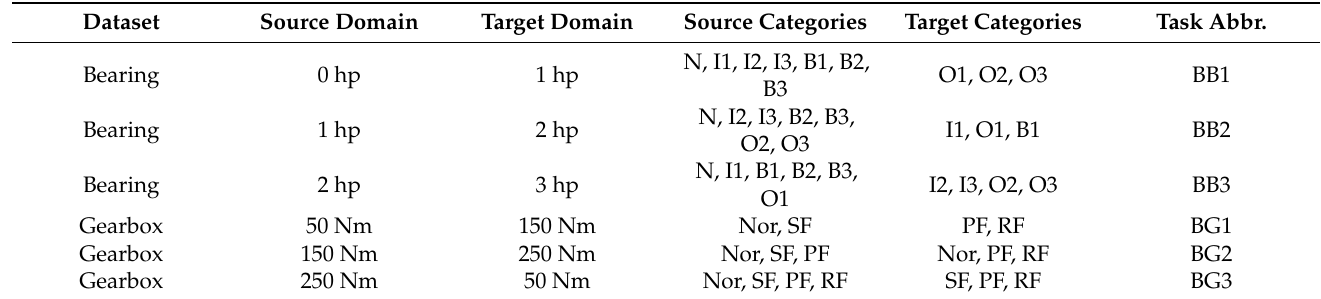
Table 9. Cross-domain few-shot scenarios of bearing and gearbox